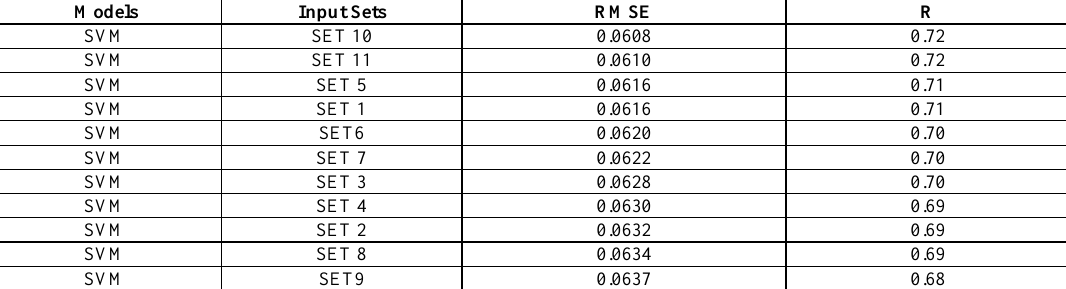
Table 4. Comparison of SVM input sets performance.